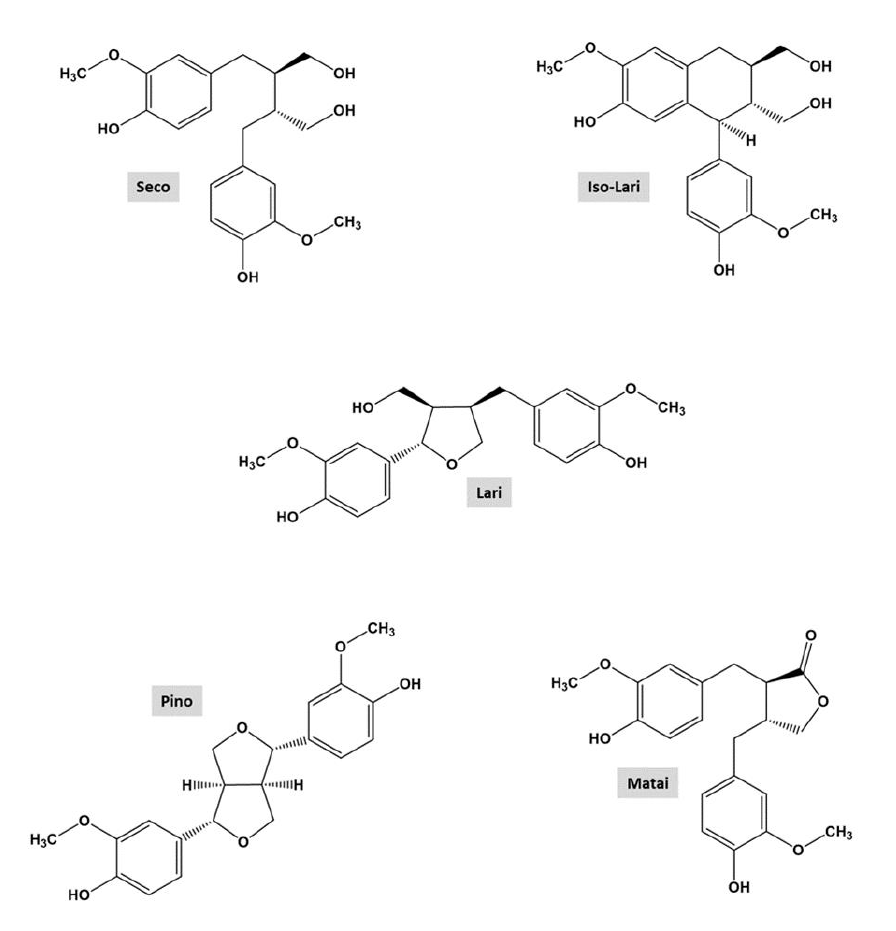
Figure 3. Chemical structures of the lignans in knotwood of silver fir ( Abies alba Mill): secoisolariciresinol (Seco), isolariciresinol (Iso-Lari), lariciresinol (Lari), pinoresinol (Pino), matairesinol (Ma- tai).